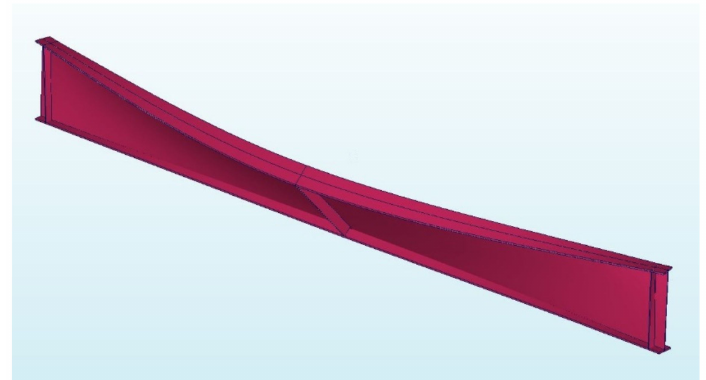
Figure A1. The 1st buckling mode, α cr = 1.8, scale × 2, computer code [33].